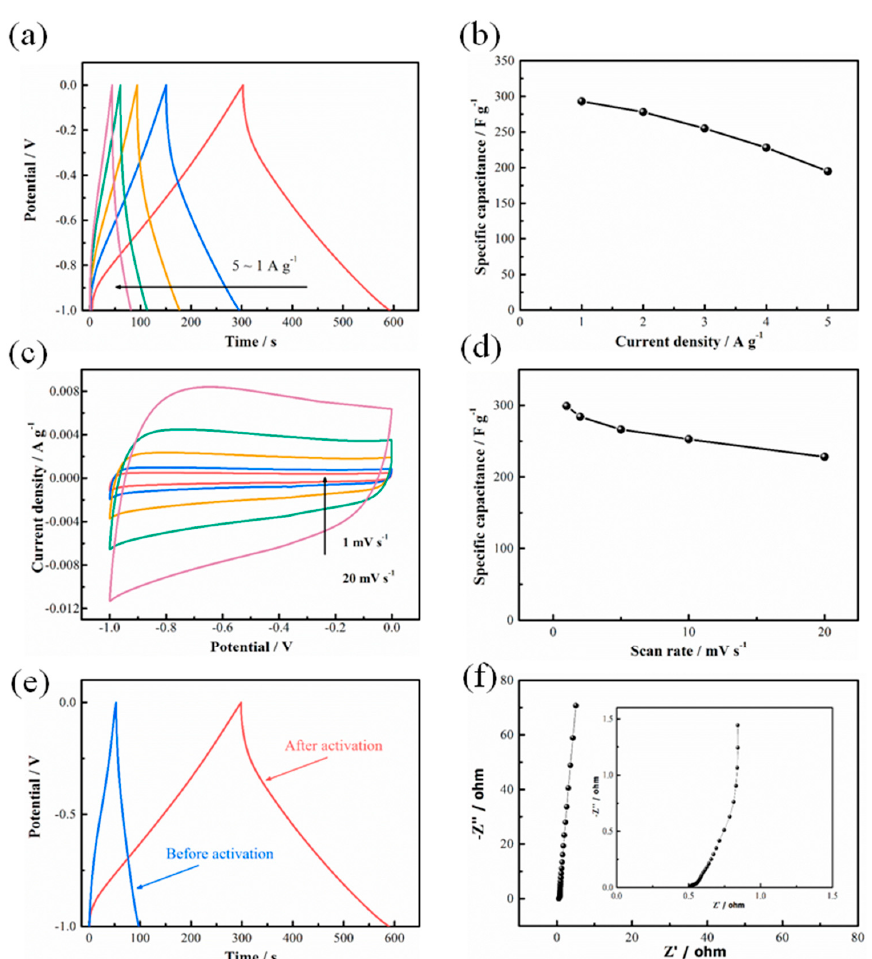
Figure 4. Electrode materials electrochemical tests of corncob-derived carbon materials ( a ) GCD curves of pyrolyzed-activated carbon materials in current densities of 1, 2, 3, 4 and 5 A·g − 1 and ( b ) their rate capabilities; ( c ) CV curves of pyrolyzed-activated carbon materials in different scan rates at 1, 5, 10, 15 and 20 mV·s − 1 ; ( d ) corresponding rate capabilities; ( e ) GCD curves of corncob-derived carbon materials before and after activation process; ( f ) Nyquist plots of pyrolyzed-activated carbon materials with an enlarged high frequency region.